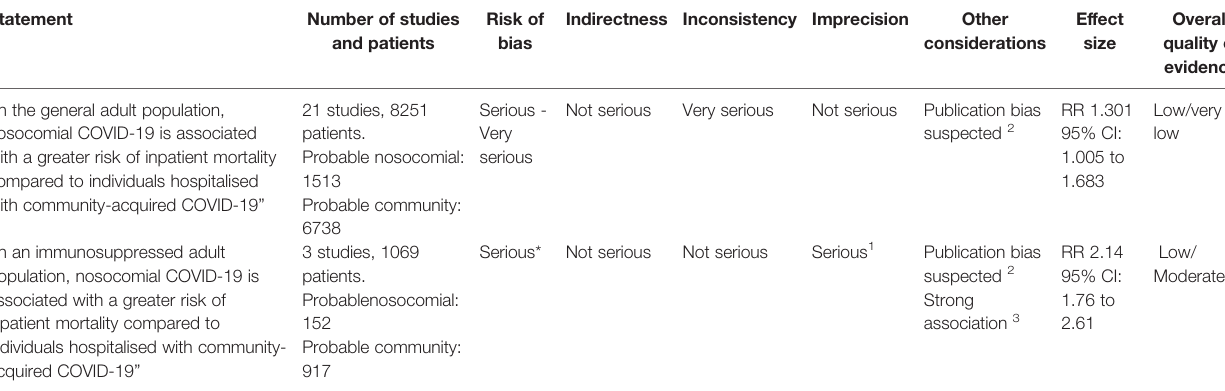
TABLE 6 | Grading of Recommendations, Assessment, Development and Evaluations (GRADE)